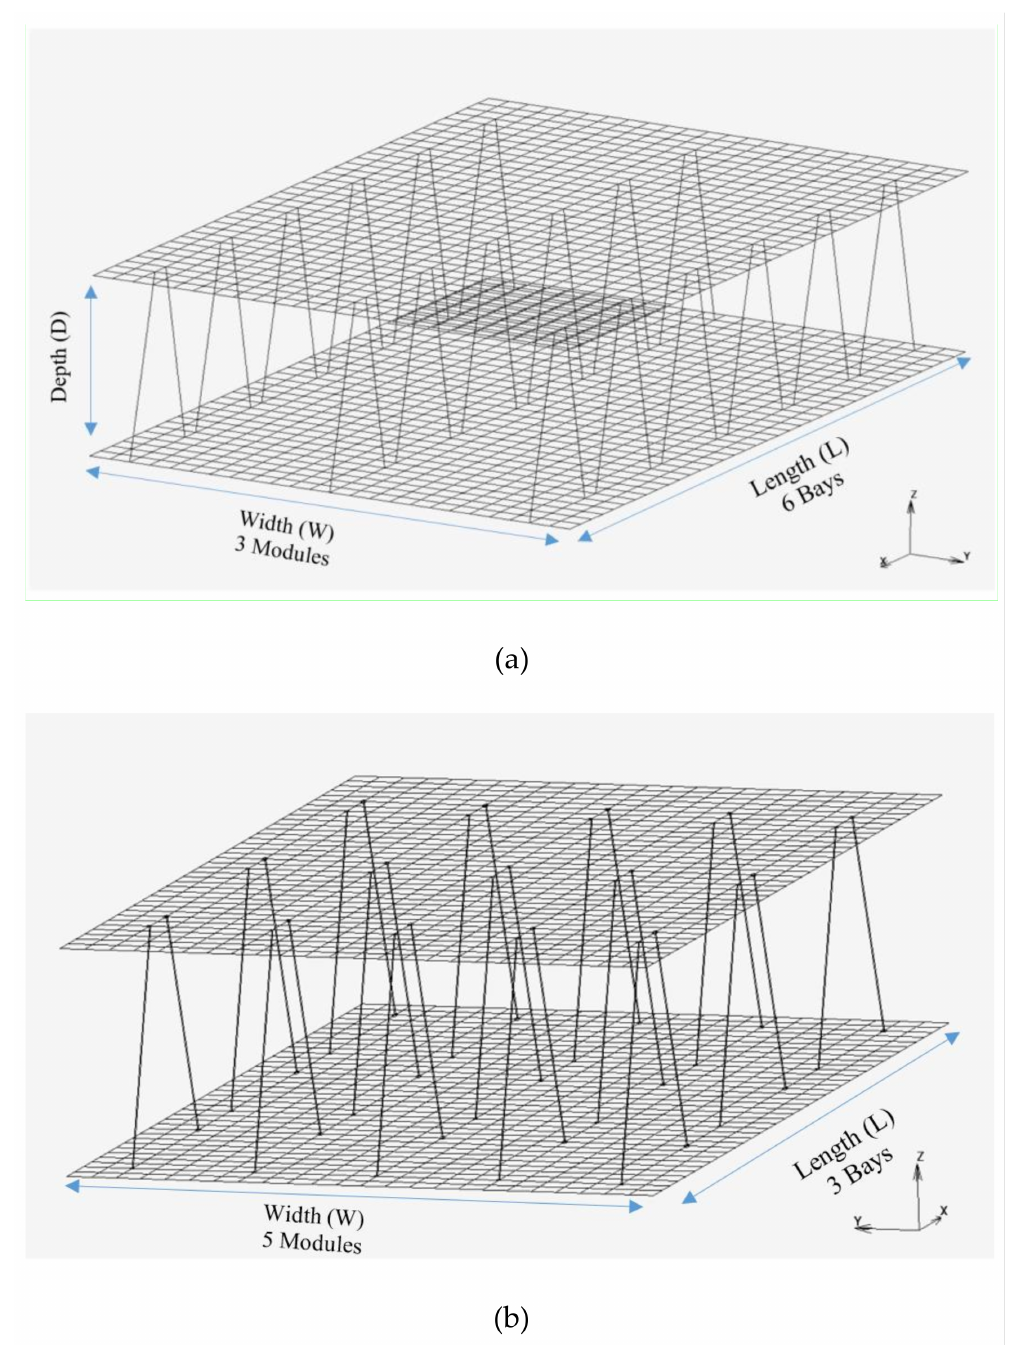
Figure 7. Design option for structural configuration: ( a ) three modules with 6 bays, ( b ) five modules with 3